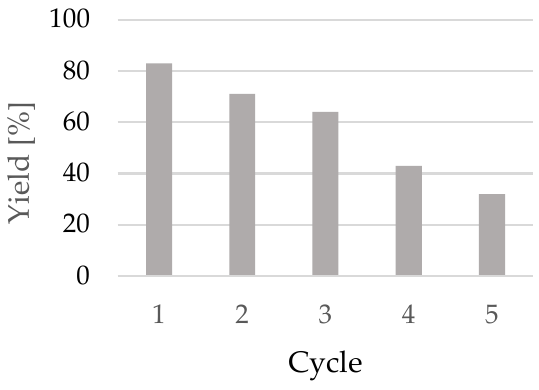
Figure 2. Reusability of Candida cylindracea lipase in 1 synthesis. Reaction conditions: benzaldehyde (1 mmol), malononitrile (1 mmol), dimethyl phosphite (1 mmol) in TBME (2 mL) for 8 h, 200 rpm.